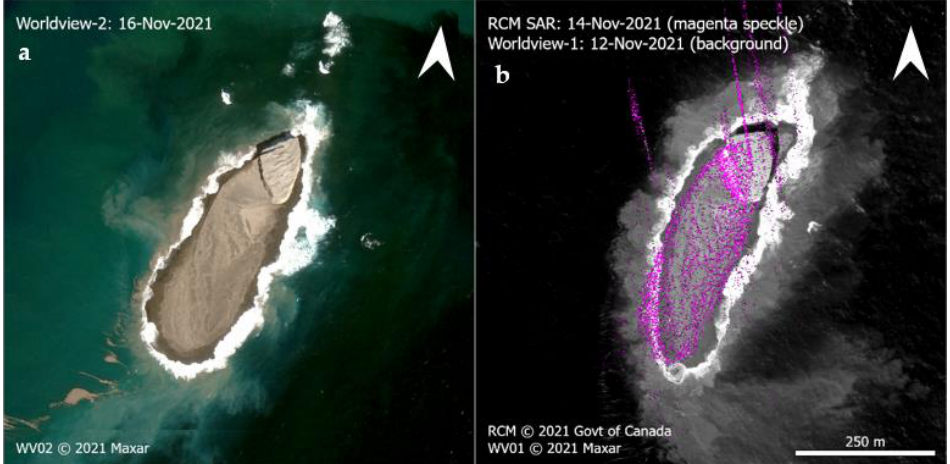
Figure 7. Examples of 2D high resolution satellite images from Maxar Worldview ( a ) at meter resolution revealing the 20+ m (relief) remnant of the early NFO island (northern polygonal feature with light-toned appearance), and ( b ) CSA Radarsat Constellation Mission (RCM) C-band Spotlight SAR image (1 × 3 m resolution), with HH/HV/HH polarizations displayed in RGB, mapped atop a nearly-coincident optical image from Maxar Worldview-1. These 2D imaging datasets illustrate the dynamic state of erosion and the importance of the independent vertical perspective provided by satellite lidar altimetry (and bathymetry) from ICESat-2. RADARSAT Constellation Mission Imagery © Government of Canada (2021); RADARSAT is an official mark of the Canadian Space Agency.